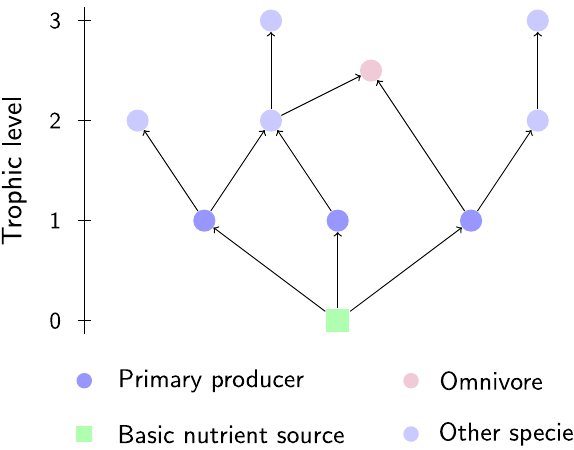
Figure 6. Example of an evolved food web. Species types as indicated in the legend. The vertical axis marks the trophic level, l . A species’ trophic position is defined using average food chain